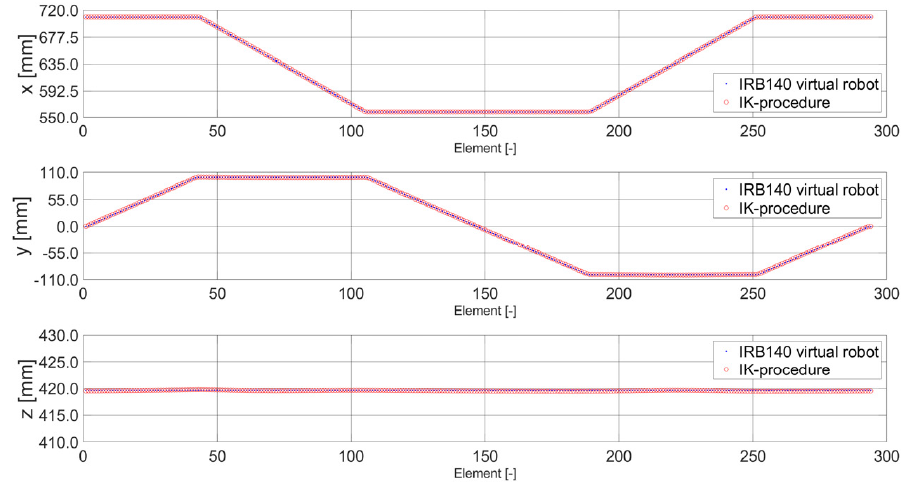
Figure 9. Rectangle in the X-Y plane: X-, Y-, Z- axes Virtual IRB140 vs. IK procedure.